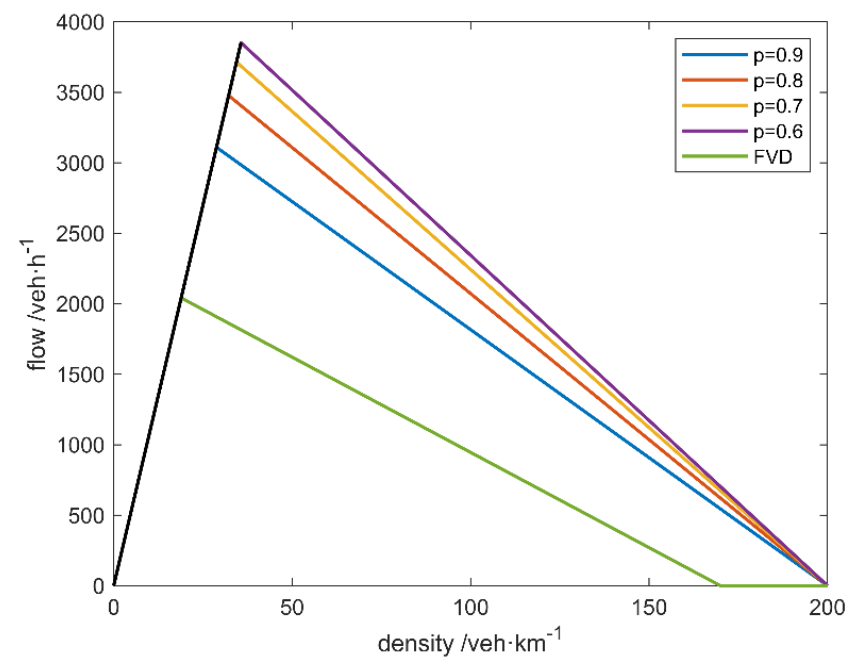
Figure 6. The fundamental diagram represented by the volume–density relationship.